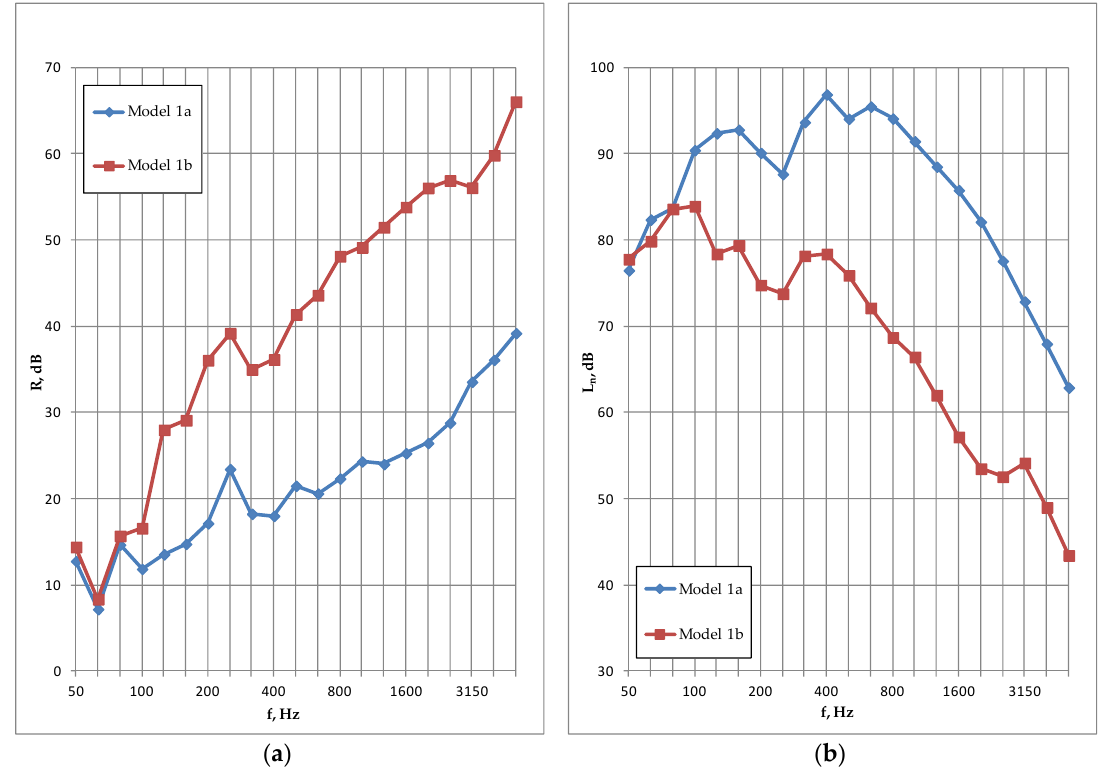
Figure 7. Airborne ( a ) and impact ( b ) sound insulation test results of the wooden floor (models 1a and 1b).